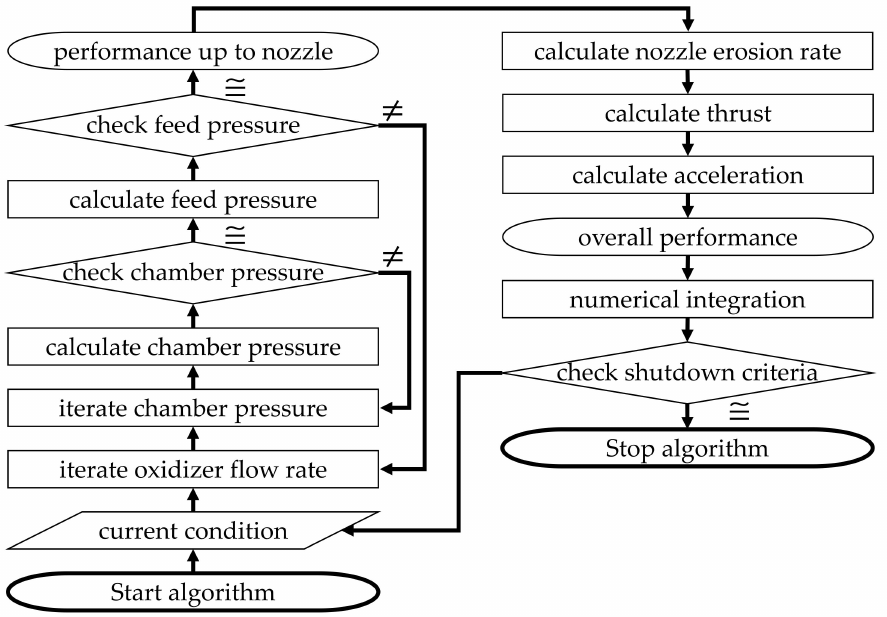
Figure 9. Computational flow chart of the hybrid rockets internal ballistics simulation